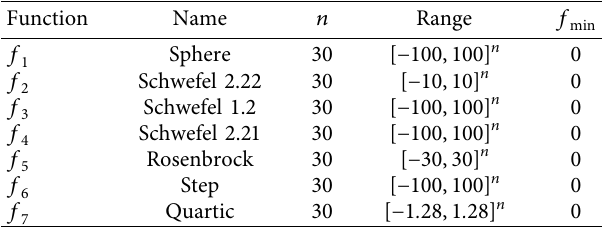
A LGORITHM 4: Improved Algorithm. Table 1: Unimodal benchmark functions.